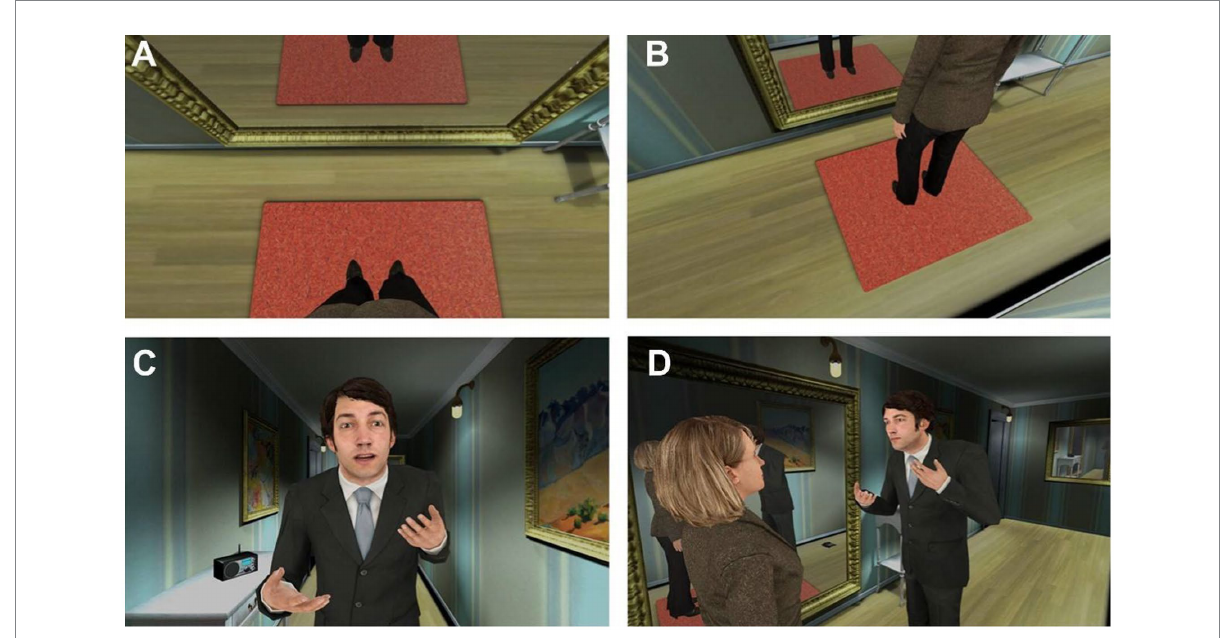
FIGURE 2 First- versus third-person perspective. (A) The participant looks down towards his body and sees the virtual body. (B) A third-person perspective (with no body) over the scenario, where the female character is looking towards a mirror. (C) The virtual abuser invades the space of the participant who is embodied as the woman. (D) A third person view of the situation shown in (C) . Source: Gonzalez-Liencres et al. (2020) (CC-BY